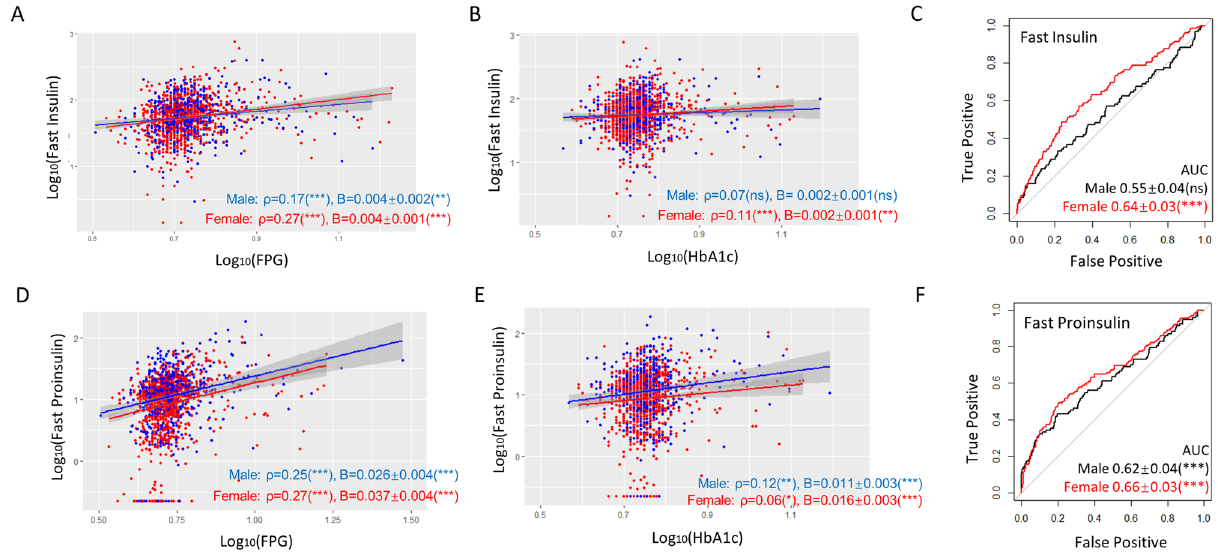
Figure 4. Fasting insulin and proinsulin levels predict T2D better in women than in men. ( A , B ) Fasting insulin levels associate with and affect FPG and HbA1c stronger in women than in men as judge from Spearman’s ρ and regression coefficient B. P values, regression constant can be found in Tables S2 and S3. ( C ) Fasting insulin is a stronger T2D predictor for women as judged by ROC-AUC values. ( D ) Fasting proinsulin levels associate with and affect FPG and HbA1c stronger in women than in men. ( E ) Fasting proinsulin levels are weakly associated with HbA1c in women. ( F ) Fasting proinsulin is a stronger T2D predictor for women as judged by ROC-AUC values. AUC area under the curve, ns not significant, **P < 0.01, ***P <